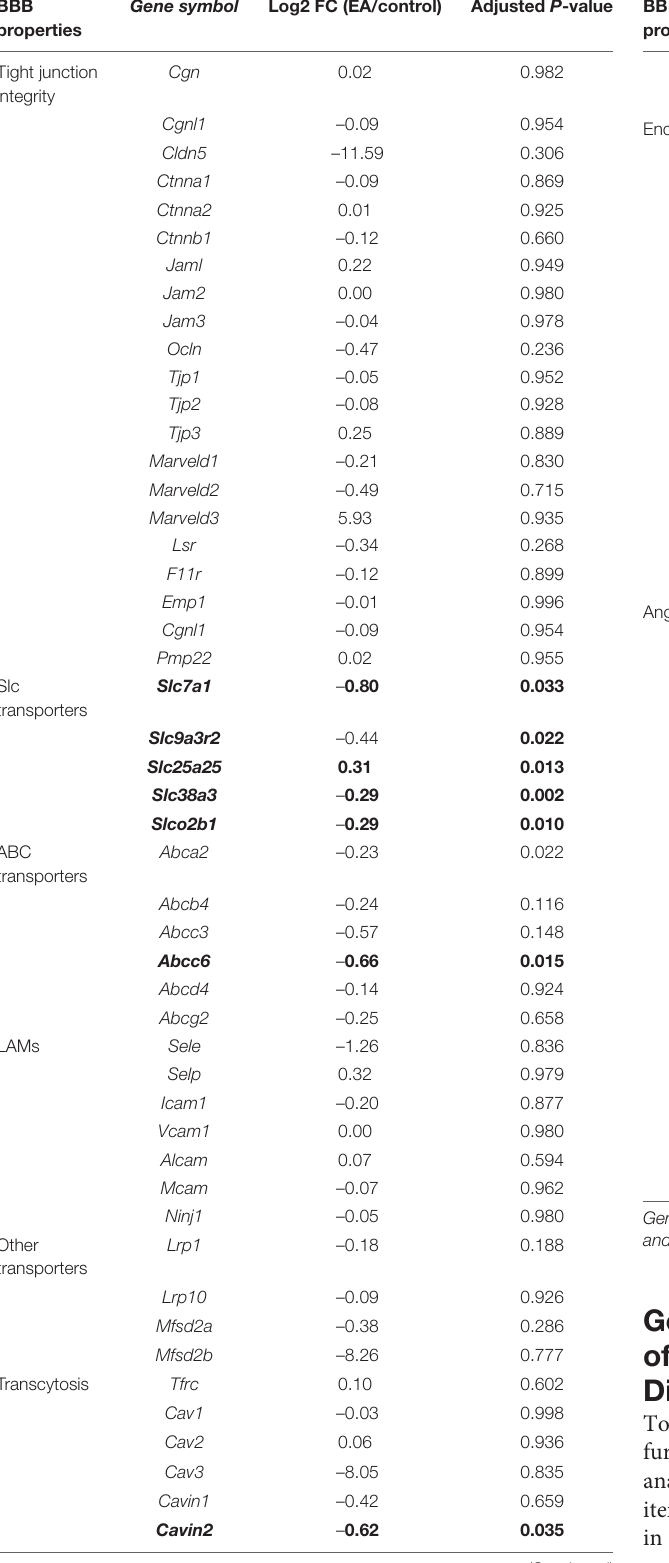
TABLE 3 | Genes related to blood-brain